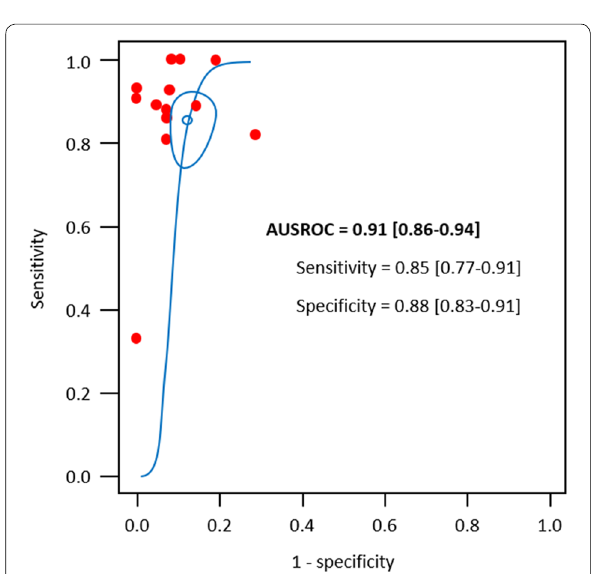
Fig. 3 AUSROC curve for the Reitsma et al. [26] bivariate model. Pair of pooled accuracies together with a 95% confidence region is represented. AUSROC: area under the summary receiver operating